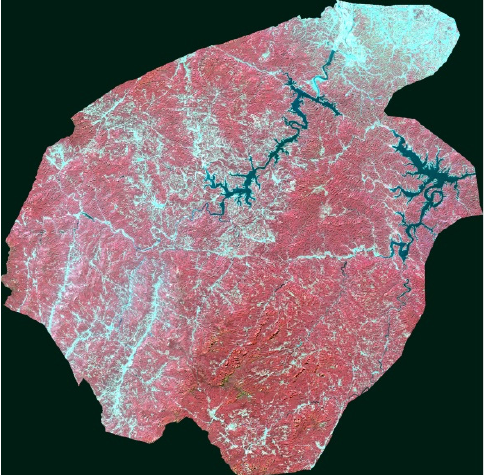
Figure 4. False color composite image (bands 4-3-2) of the study area after atmospheric and terrain related preprocessing.